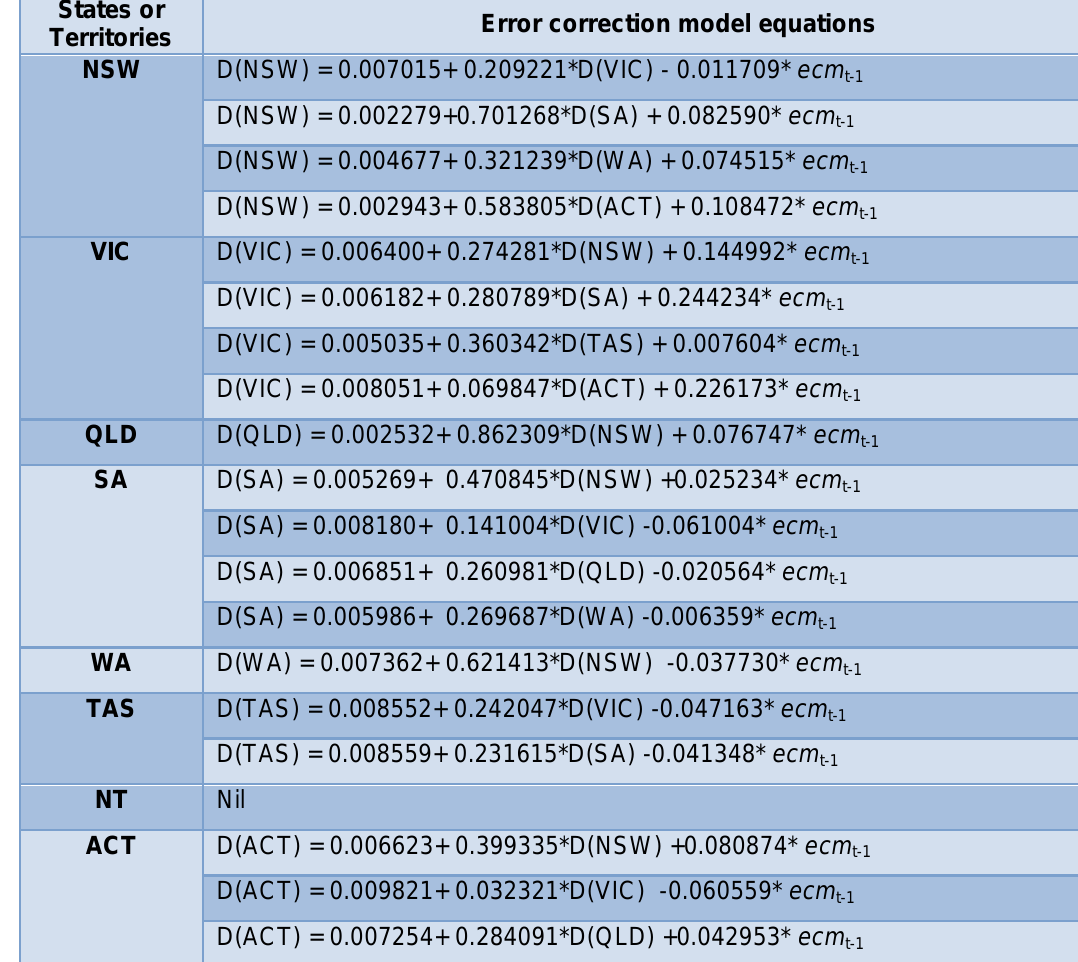
Table 4 Error correction models of construction producer price indices Jiang et al. (2011) indicated that when the co-integration relationship exists, it is considered that a Granger causality must occur in at least one direction. The causal links between six states and two territories have been presented in Figure 3, which indicate the elasticity of changing in the diffusion of regional construction prices based on the co-integration regression test and error correction model estimations. Figure 3 shows that there are no causal relationships with the Northern Territory. In contrast, construction prices in New South Wales receives four significant positive causal effects from Victoria, South Australia, Western Australian and Australian Capital Territory. The figures also indicate that Victoria and South Australia construction prices both receive positive causal effects from four regional prices. Queensland and Western Australia are only influenced by New South Wales. The changes of New South Wales construction prices generate the most significant effects on construction prices in five regional